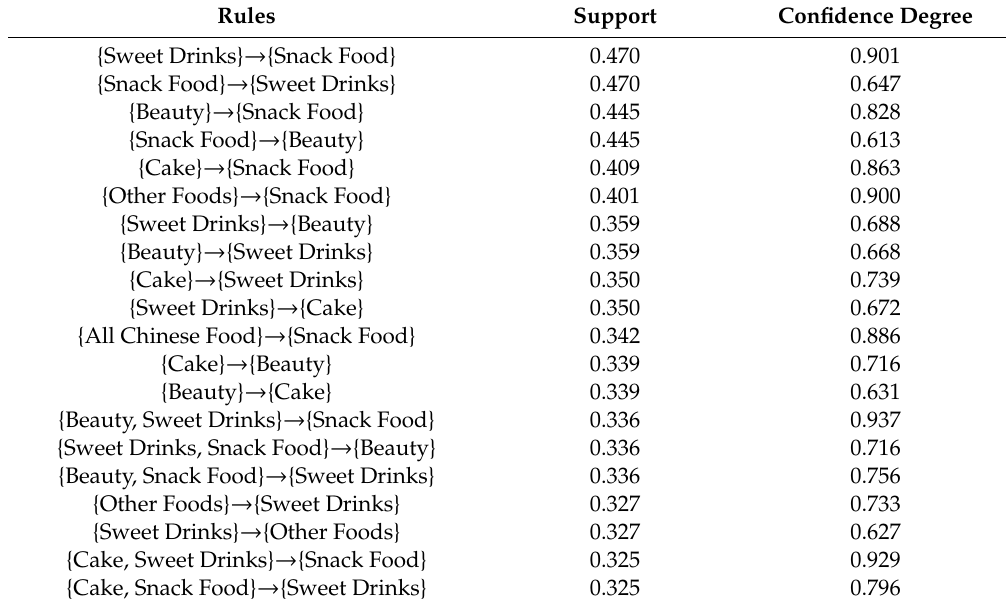
Table 4. Top 20 confident association rules from Table